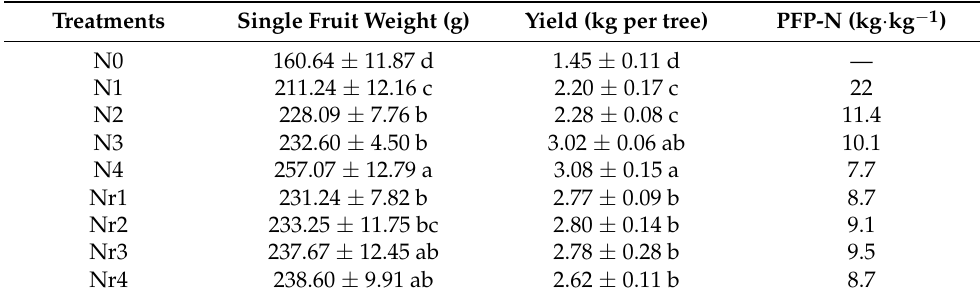
Table 6. Effects of different nitrogen application rates on single fruit weight, yields, and the nitrogen partial factor productivity (PFP-N).